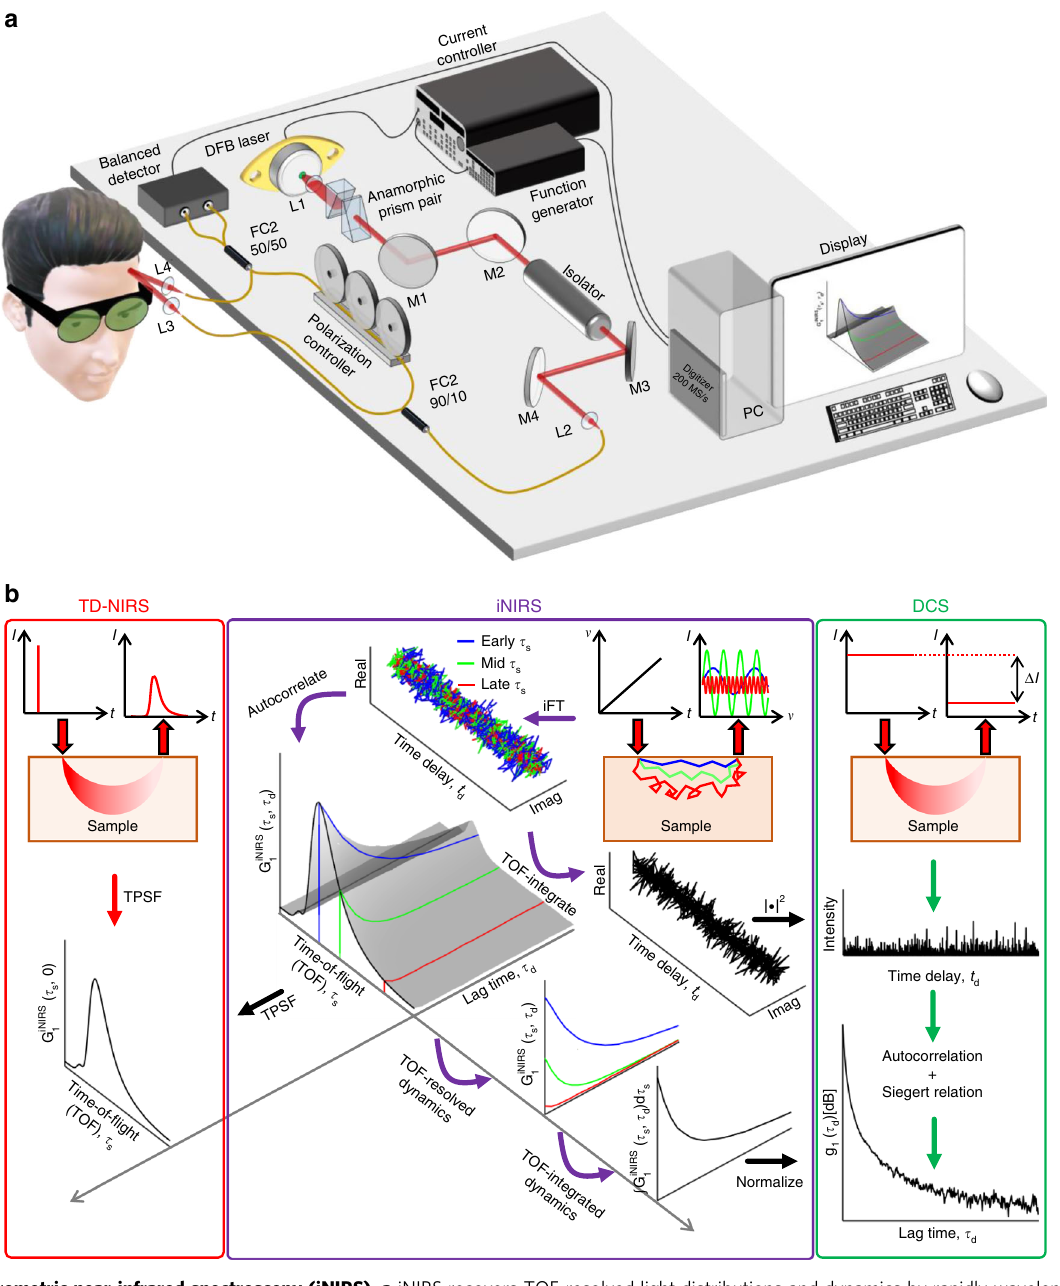
Fig. 1 Interferometric near-infrared spectroscopy (iNIRS). a iNIRS recovers TOF-resolved light distributions and dynamics by rapidly wavelength tuning a temporally coherent distributed feedback (DFB) laser. b iNIRS (center) provides a rich two-dimensional data set, G iNIRS ( τ s , τ d ), that uni fi es incoherent and 1 ( τ s , 0) provides medium temporal point spread functions (TPSFs) like time domain (TD-) NIRS coherent diffuse optics. Through incoherent averaging, G iNIRS R 1 G iNIRS (left). Through time-of- fl ight (TOF) integration, ( τ s , τ d )d τ s can provide medium autocorrelations, like diffuse correlation spectroscopy (DCS) 1 OCT Doppler velocity over the axial range in the epidermis, intensity autocorrelation, showing that phase correction restores indicated by a green arrow, with no vasculature, should yield bulk the validity of the modi fi ed Siegert relationship (see Supplemen- motion. A parametric plot of Doppler velocities over 1.9 s, Δ V = tary Note 2) 25 . α = 0°), and accounting for different center Δ f λ 0 /2 (Eq. (4) with SD wavelengths, yields excellent correlation R 2 = 0.95 (Fig. 2i) and agreement (Fig. 2j), conclusively showing that iNIRS bulk phase drift estimation was performed via simultaneous co-registered drift results from sample axial motion. comparison (Fig. 2g) with a gold standard technique, OCT, where bulk phase shifts due to motion are routinely estimated from Phase correction signi fi cantly impacts fi eld autocorrelation static tissue and corrected 30 . A standard OCT cross-section of decays at early TOFs . iNIRS was performed in an Intralipid forearm tissue reveals epidermal and dermal layers (Fig. 2h), consisting mainly of intrinsically static tissue from which OCT phantom ( μ s ′ = 10 cm − 1 , μ a ~ 0.045 cm − 1 ), human forearm, nude bulk phase shifts can be estimated 30 . In particular, the calculated mouse head, and human forehead (Fig. 3a – d). TPSFs enabled